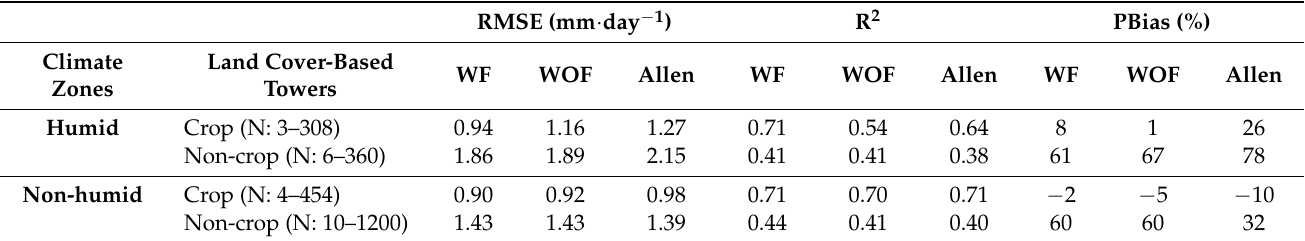
Table 5. Evaluation of automated approaches for humid climate-based tower classification (N: number of